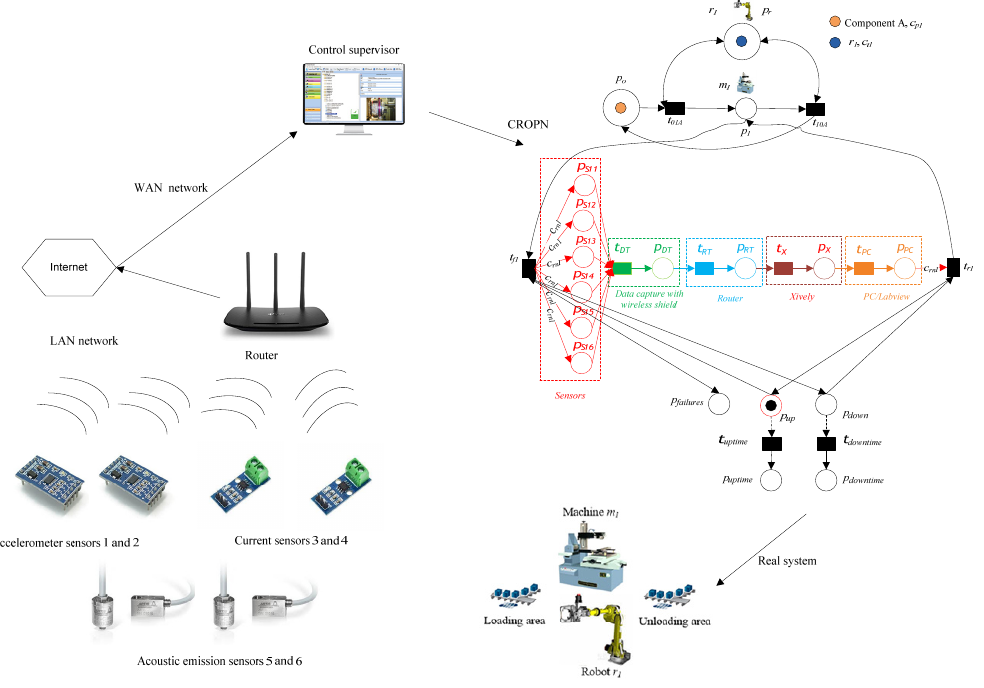
Figure 6. Graphical user interface based on IoT for an AMS presented in Figure 4. The information gathered by the “sensors” and sent to the Internet is depicted in Figure 7. It enables the filtering and graphing of data to identify potential patterns or important events. Regardless of the exact location of the sensors, the data can be accessed from anywhere on Earth.